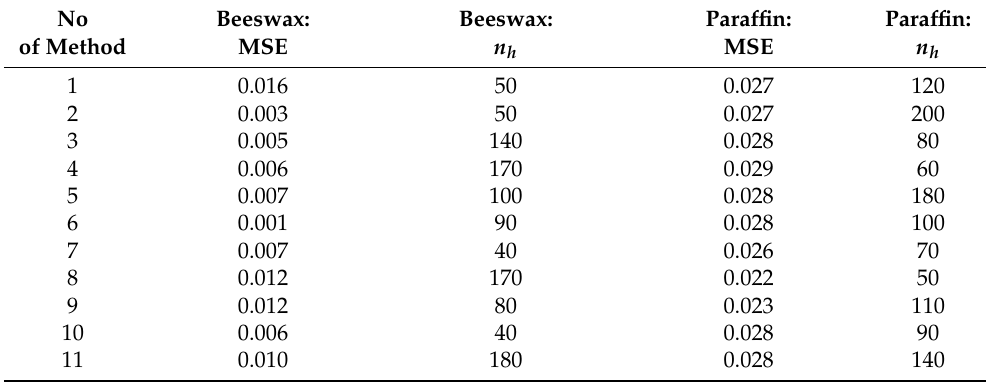
Table 2. The obtained minimum MSE and corresponding number of neurons n h in the hidden layer for the selected learning methods and the wax